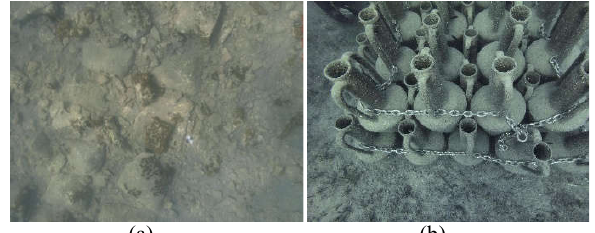
Figure 3. Corrected (a) imagery with Lαβ for shallow and deep (b)